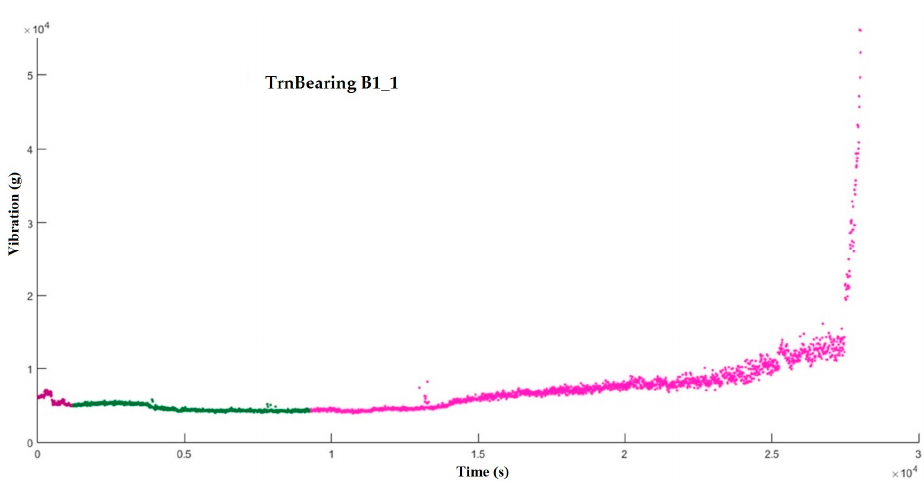
Figure 17. Reduce_Local_Search result for PRONOSTIA dataset B1_1.